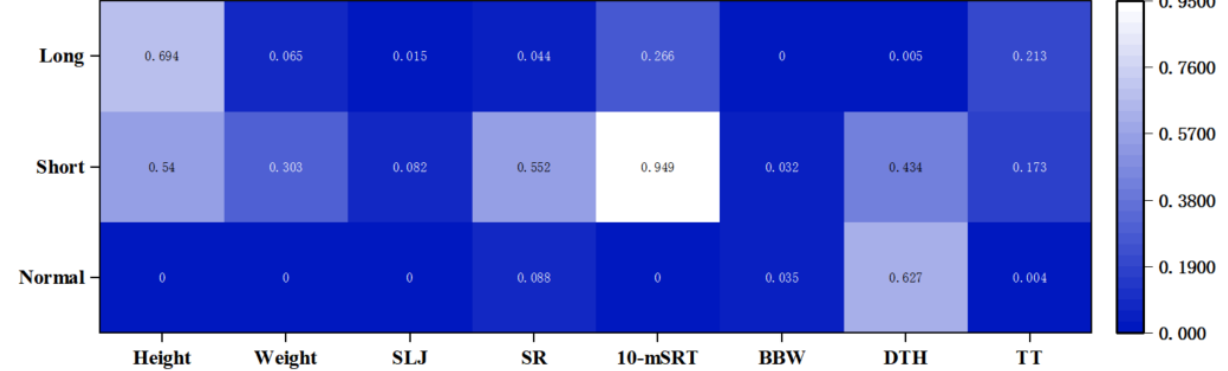
Figure 3. Correlation of the components of PF with sleep duration. SLJ: standing long jump; SR: sit-and-reach; 10-mSRT: 10 m shuttle run test; BBW: balance beam walking; DTH: double-leg timed hop; TT: tennis throwing. Normal: normal sleep duration; Short: insufficient sleep duration; Long: excessive sleep duration. The numbers in the table indicate significance coefficient, and the significance level is p < 0.05.